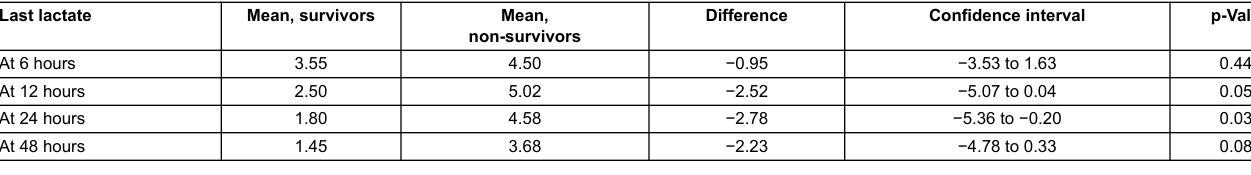
Table 2: Evolution of serum lactate during the first 48 hours of intensive